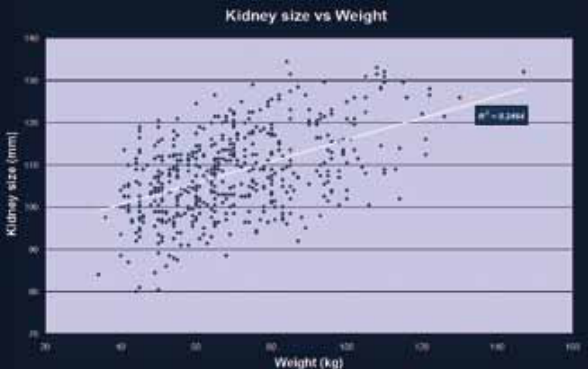
Fig. 3. Kidney size in relation to body weight.